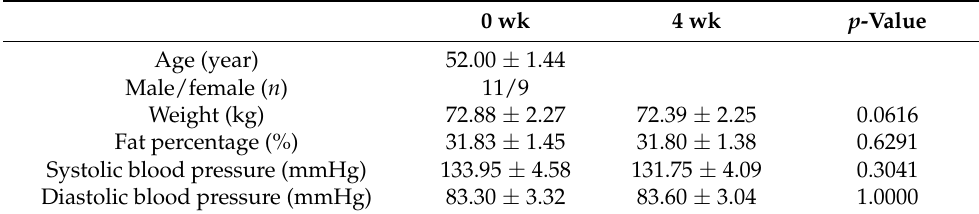
Table 1. Baseline characteristics of subjects enrolled in this